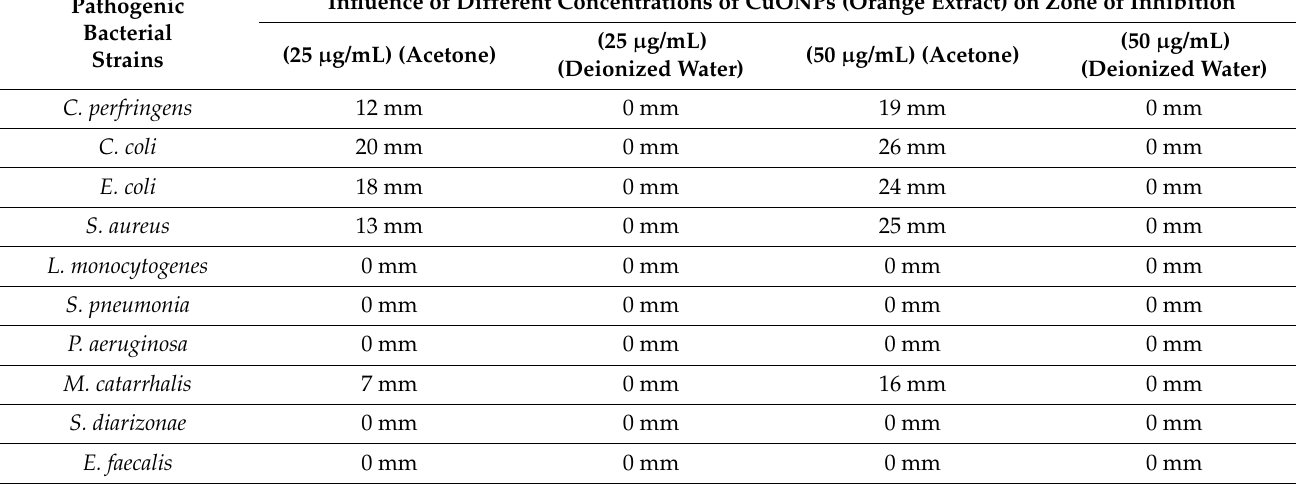
Table 2. Antibacterial activity of CuO-NPs-O on pathogenic bacterial strains. Pathogenic Bacterial